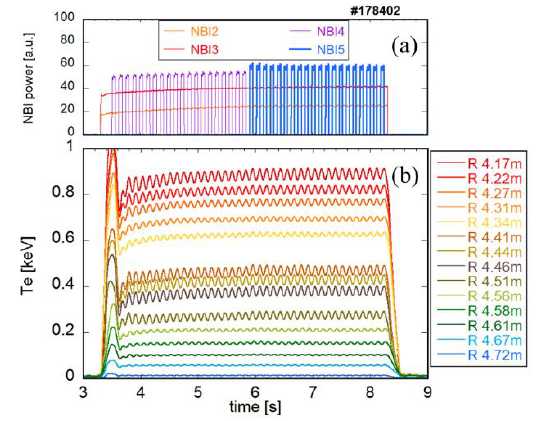
Fig. 12. Time variation observation of T e in NBI power modulation experiments. (a) Incident modulated power of the four NBIs and (b) time variation of the converted signal intensity T e at each radial position of the ECE.